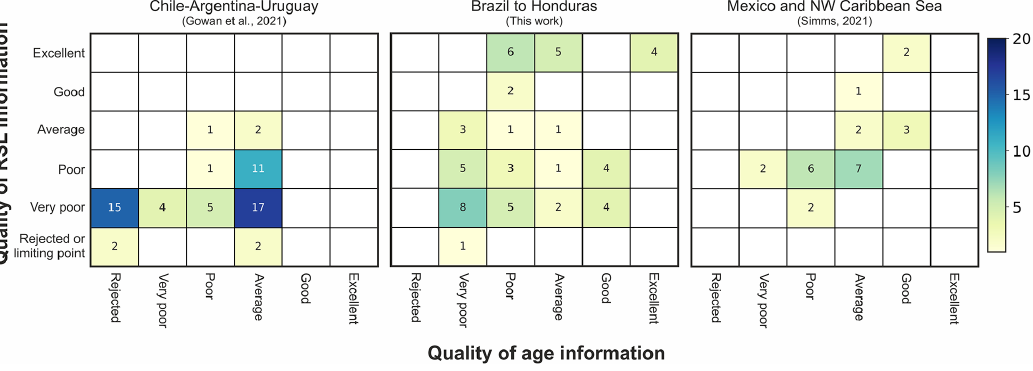
Figure 10. Quality of RSL and age information as estimated by (from left to right) Gowan et al. (2021) for Chile–Argentina–Uruguay, Brazil–Honduras (this study), and Mexico and the NW Caribbean Sea (Simms, 2021). All studies used the same rationale to give a score to age and RSL information (see Rovere et al.,